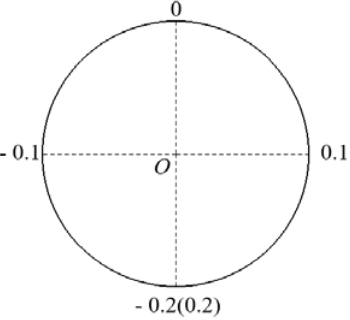
Figure 15. Coordinate system for the cylinder surface.